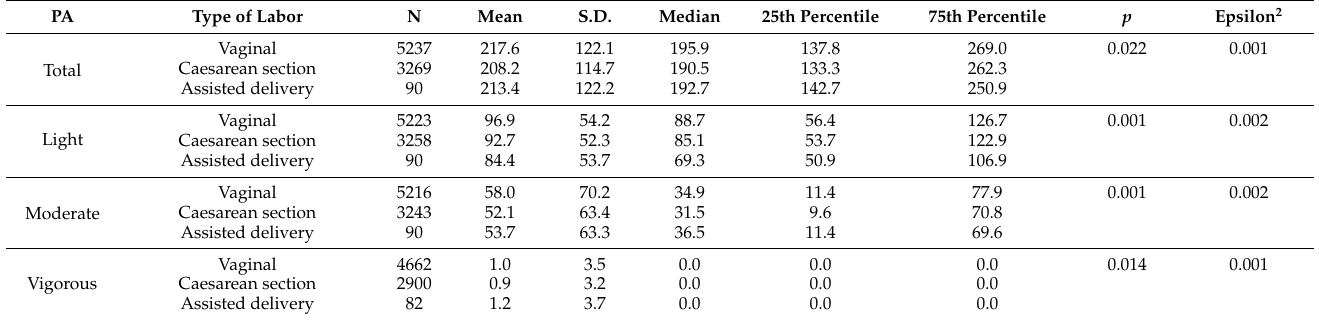
Table 4. Impact of energy expenditure of pregnant women (MET-h/week) on the type of labor.